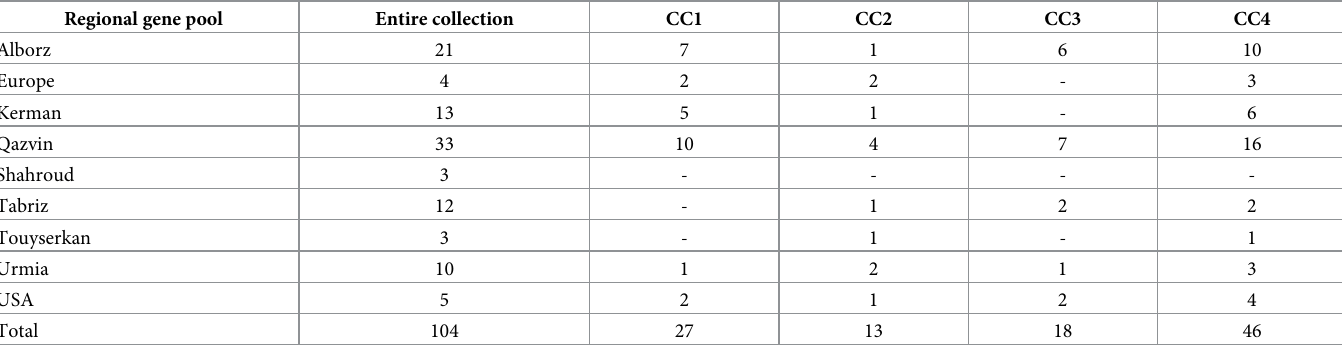
Table 3. Representation from different regions in the developed walnut Core Collections (CC). Regional gene